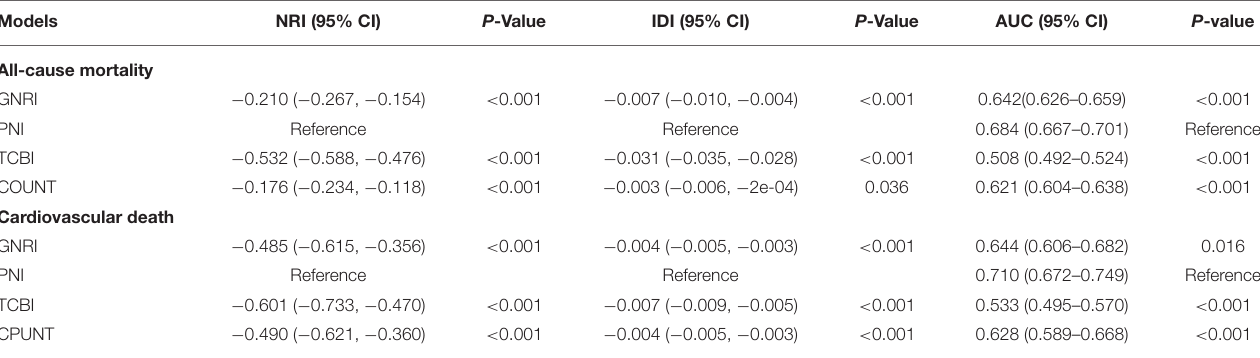
TABLE 4 | Comparisons of AUC, IDI, and NRI for GNRI, PNI, TCBI and